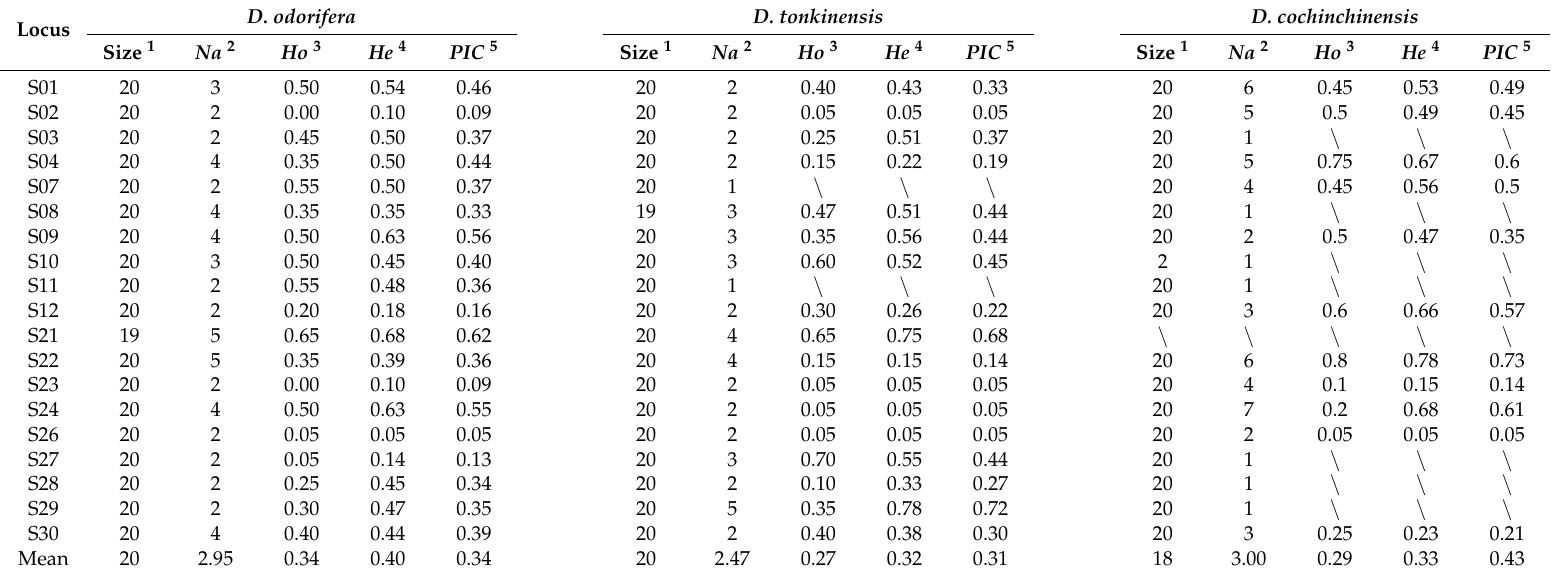
Table 5. Polymorphism of 19 SSR markers in D. odorifera , D. tonkinensis , and D. cochinchinensis